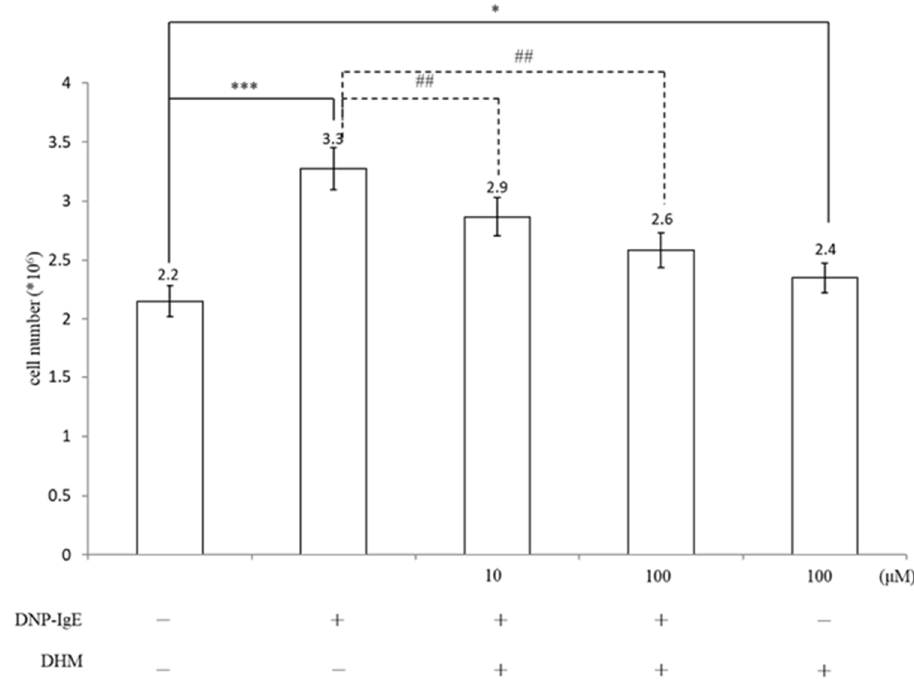
Figure 1. Effect of DHM on the proliferation of KU812 cells. Cell proliferation was assessed by trypan blue assay. Results show the fold relative to the control. Data represent the mean ± SD of three independent experiments. * p < 0.05, ** p < 0.01, *** p < 0.001 as compared with untreated control and # p < 0.0 5 , ## p < 0.01 as compared with DNP-IgE.